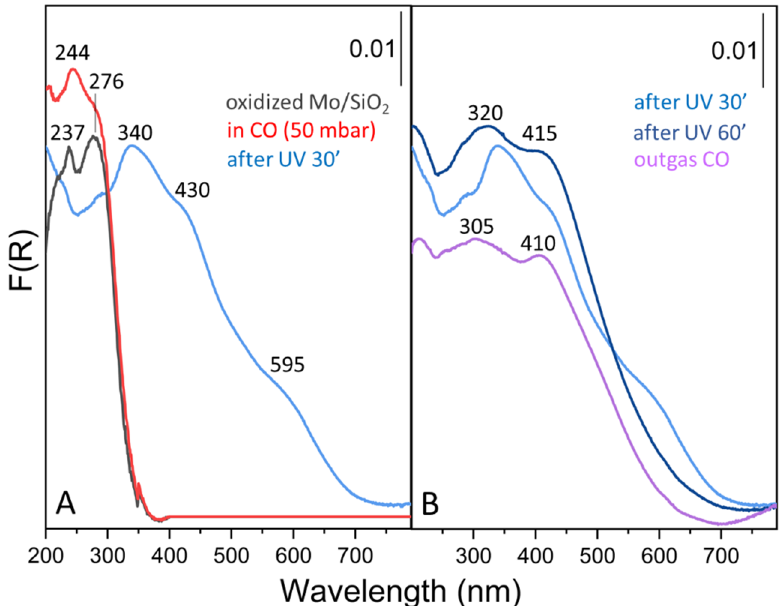
Figure 4. Diffuse reflectance spectra of the Mo/SiO 2 system. ( A ) In the initial fully oxidized conditions (black curve), after CO admission (red curve) and after UV irradiation for 30 min. ( B ) Effect of UV irradiation up to 60 min (blue curves) and of CO outgassing (purple curve).